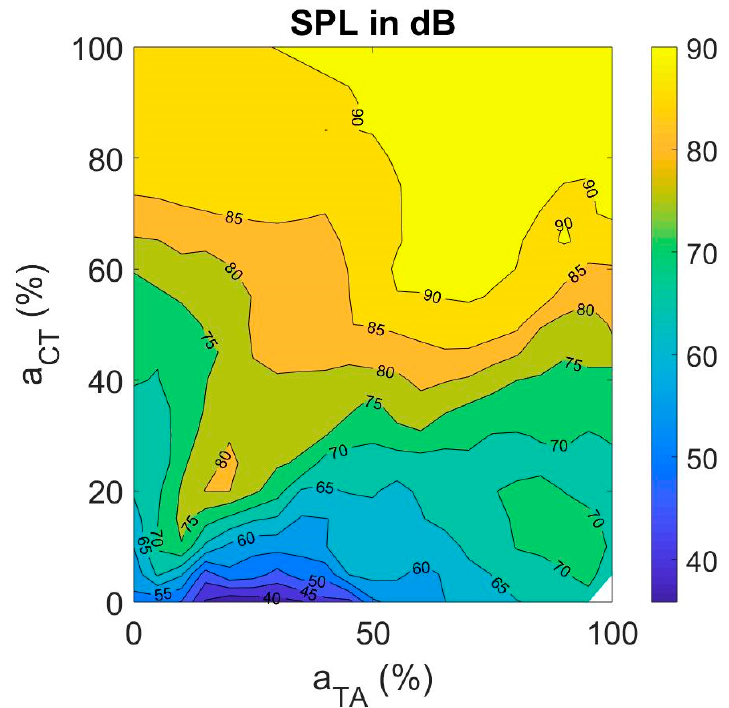
Figure 6. Muscle activation plots with sound pressure level (SPL) as the contour feature.